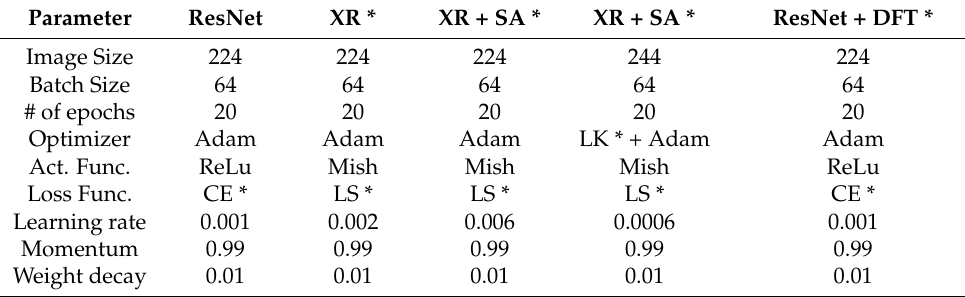
Table 3. Training Parameters for each